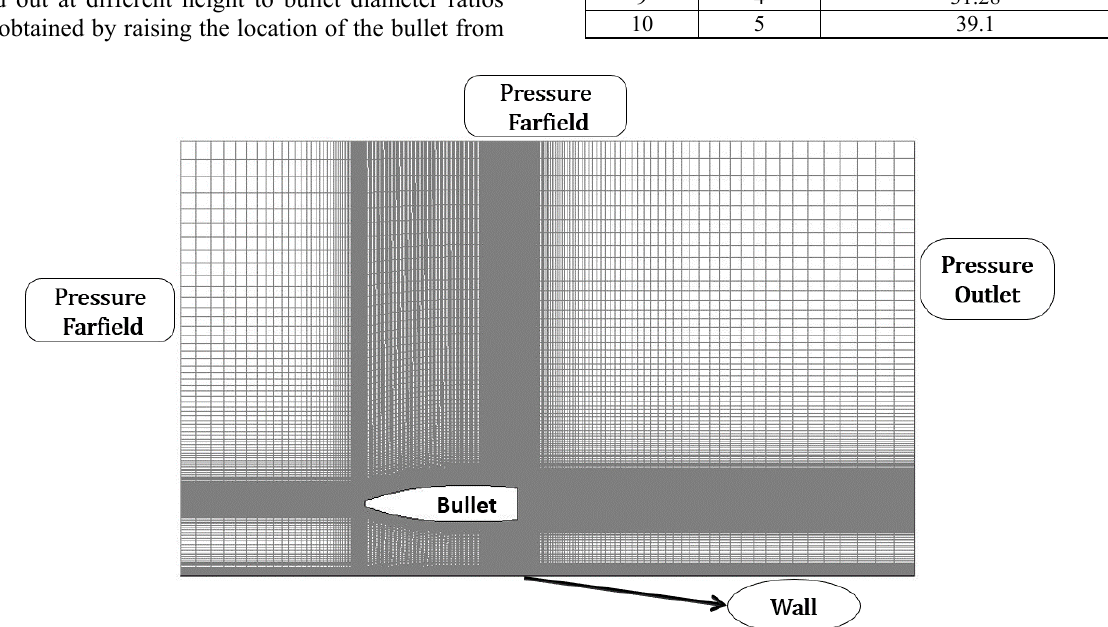
Figure 3. The computational domain adopted in the present study is near wall proximity to the bullet.